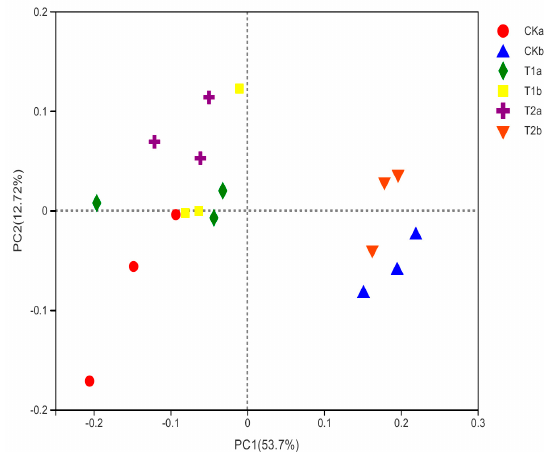
Figure 2. Principle coordinate analysis of soil bacterial community on genus level.